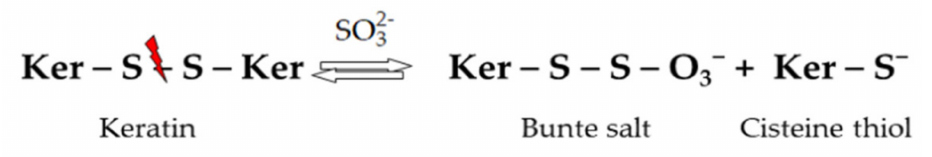
Figure 3. Sulfitolysis of